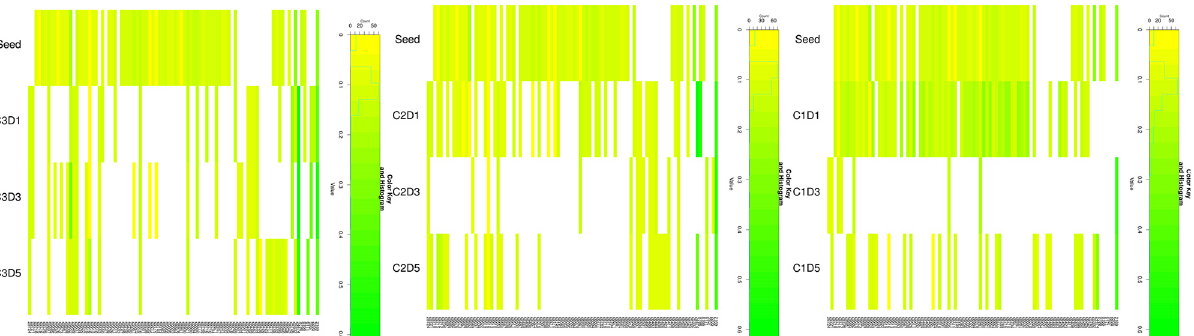
Fig 3. Heat maps of nonsynonymous iSNV frequencies and nt positions. Heat maps for each camel (A-C) show the frequencies and positions of iSNVs for each camel and time point, and for Seed inoculum. The number (count) of iSNV for each frequency value is shown along with the heat map color key is shown above each camel